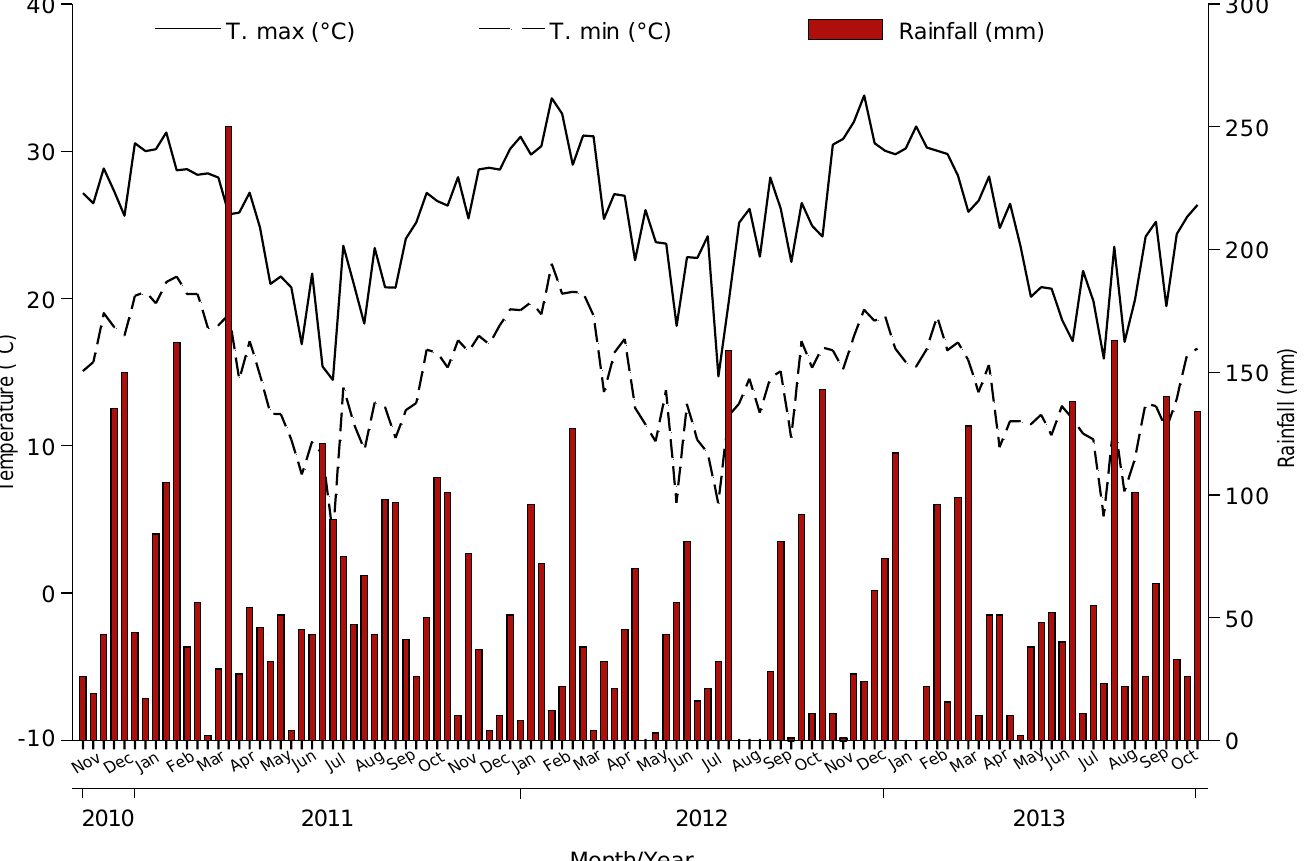
Figure 1. Rainfall and maximum and minimum temperature recorded in the experiment during the 2011/2013 crop seasons in Concordia, SC, Brazil. Temperature and rainfall were reported as the average and sum of values registered during consecutive 10 days periods,